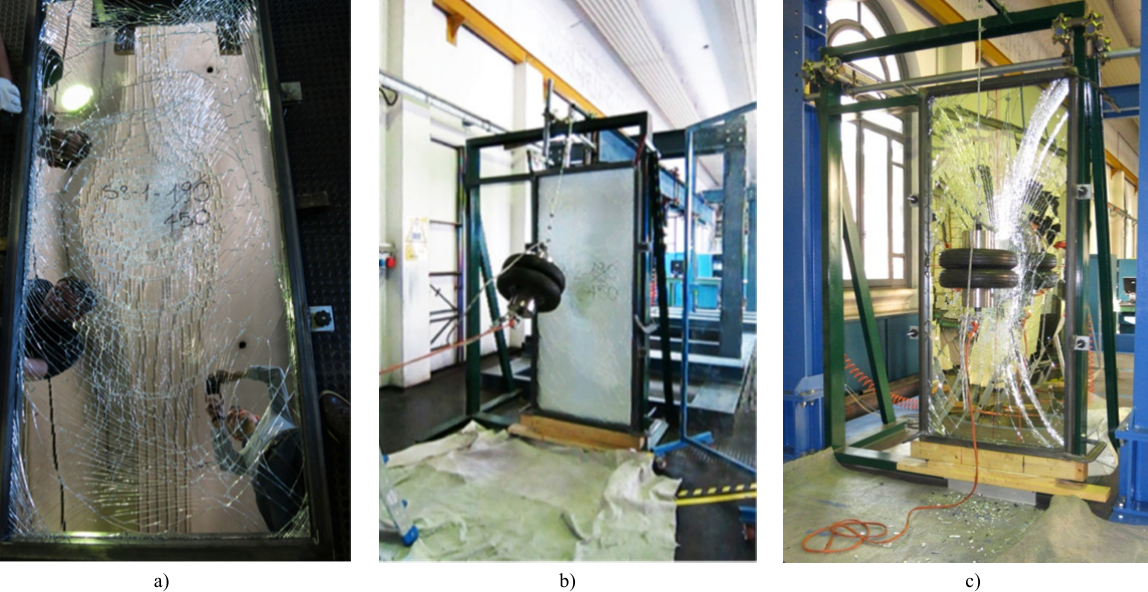
Fig. 2 S8, V8 and R8 panels following impact at a drop height of 450 mm ( a), b) and c),